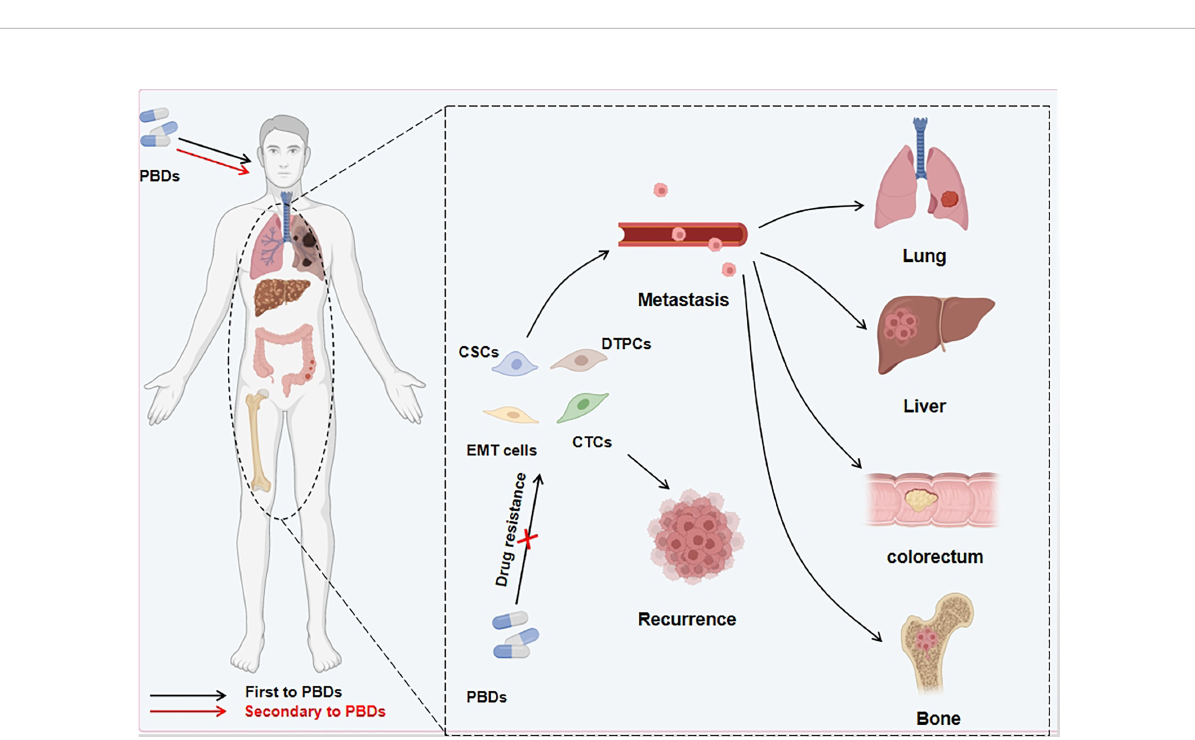
FIGURE 3 PBDs induce drug resistance through EMT in cancer cells. Platinum-based drugs can induce EMT through multiple sites/pathways and are either fully or partially transformed. In addition to the mesenchymal-like phenotype of tumor cells, a small number of other phenotypes appear during this process. Other cell types include persistent drug-resistant cells, cancer stem cells, and circulating tumor cells. These EMT-related cells can evade the deadly effect of PBDs, migrate to distant tissues and organs via the blood circulation and other routes, and cause in situ tumor relapse and metastatic foci after stopping